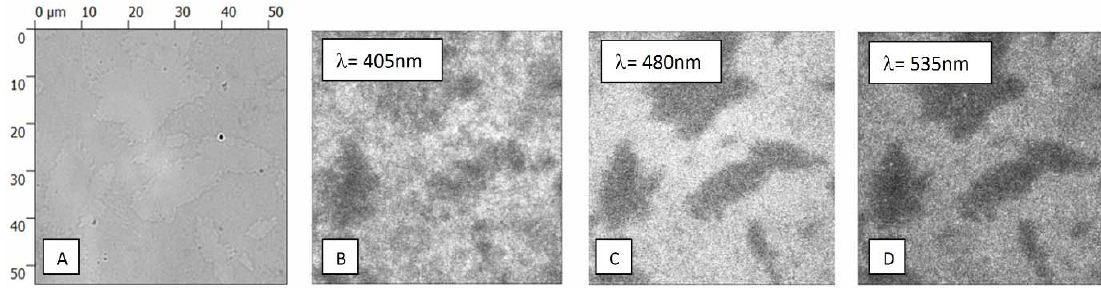
Figure 6. ( A ) Transmission microscopic image of the sample with PSI complexes deposited on rGO. ( B – D ) Fluorescence maps acquired for the same sample area using three different excitation wavelengths of 405 nm, 480 nm, and 535 nm.